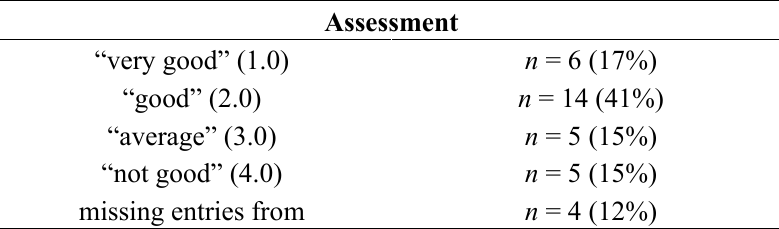
Table 4. Evaluation of usability and acceptance by